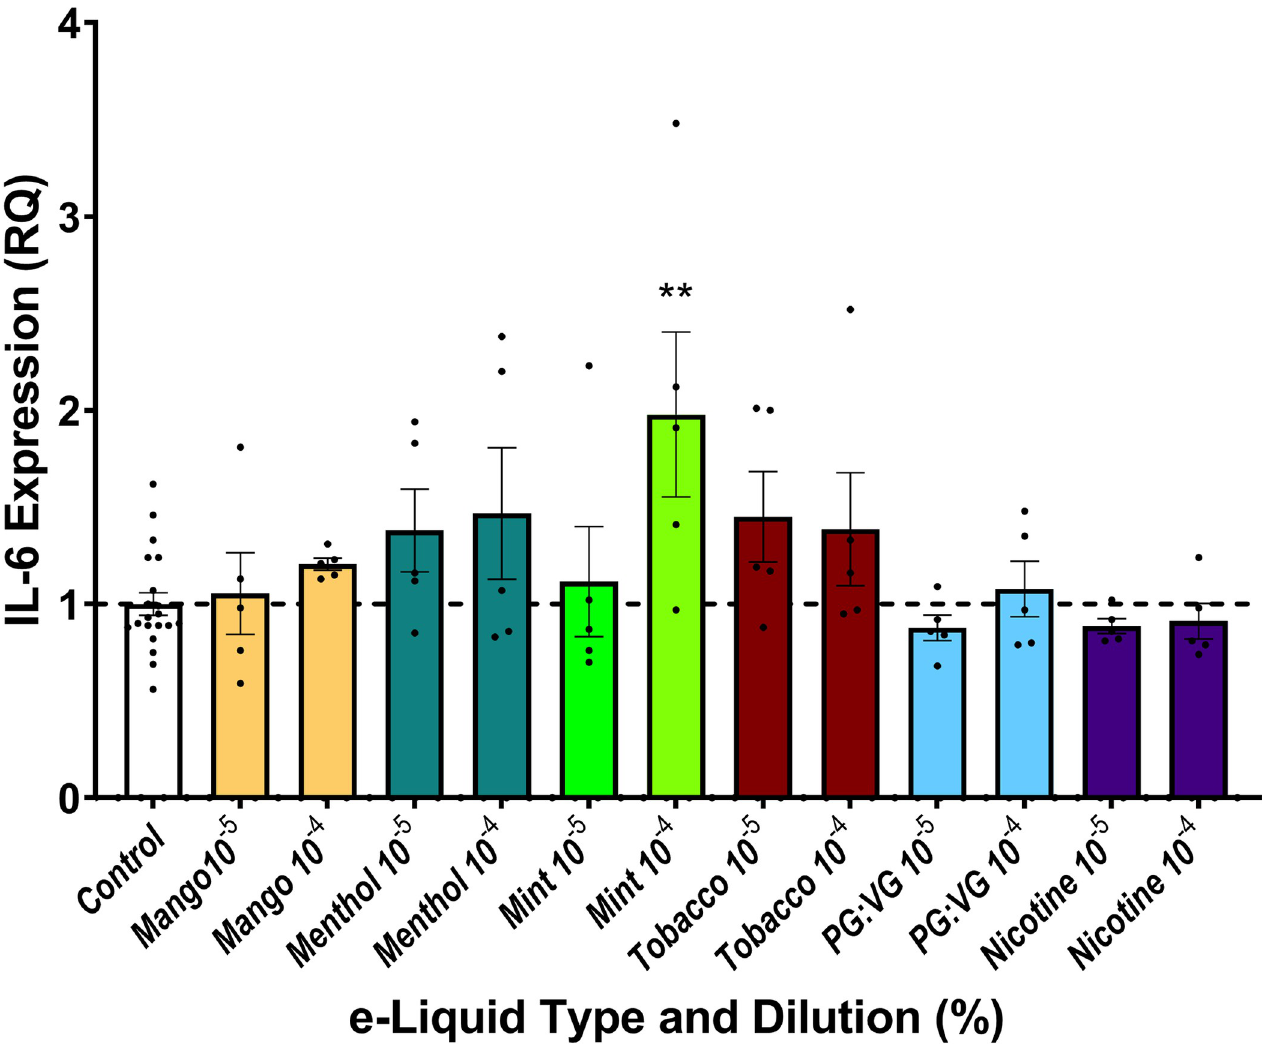
Fig 5. Inflammatory gene expression and pod e-liquid exposure. Interleukin-6 (IL-6) expression in endothelial cells was quantified using reverse transcription-quantitative PCR, respectively. All 2 - ΔΔ CT values were computed relative to untreated cells, and comparisons were made between the control and tested dilutions of each e-liquid (n = 5). Data are expressed as gene expression levels normalized to matched controls. RQ = relative quantification. �� indicates p <